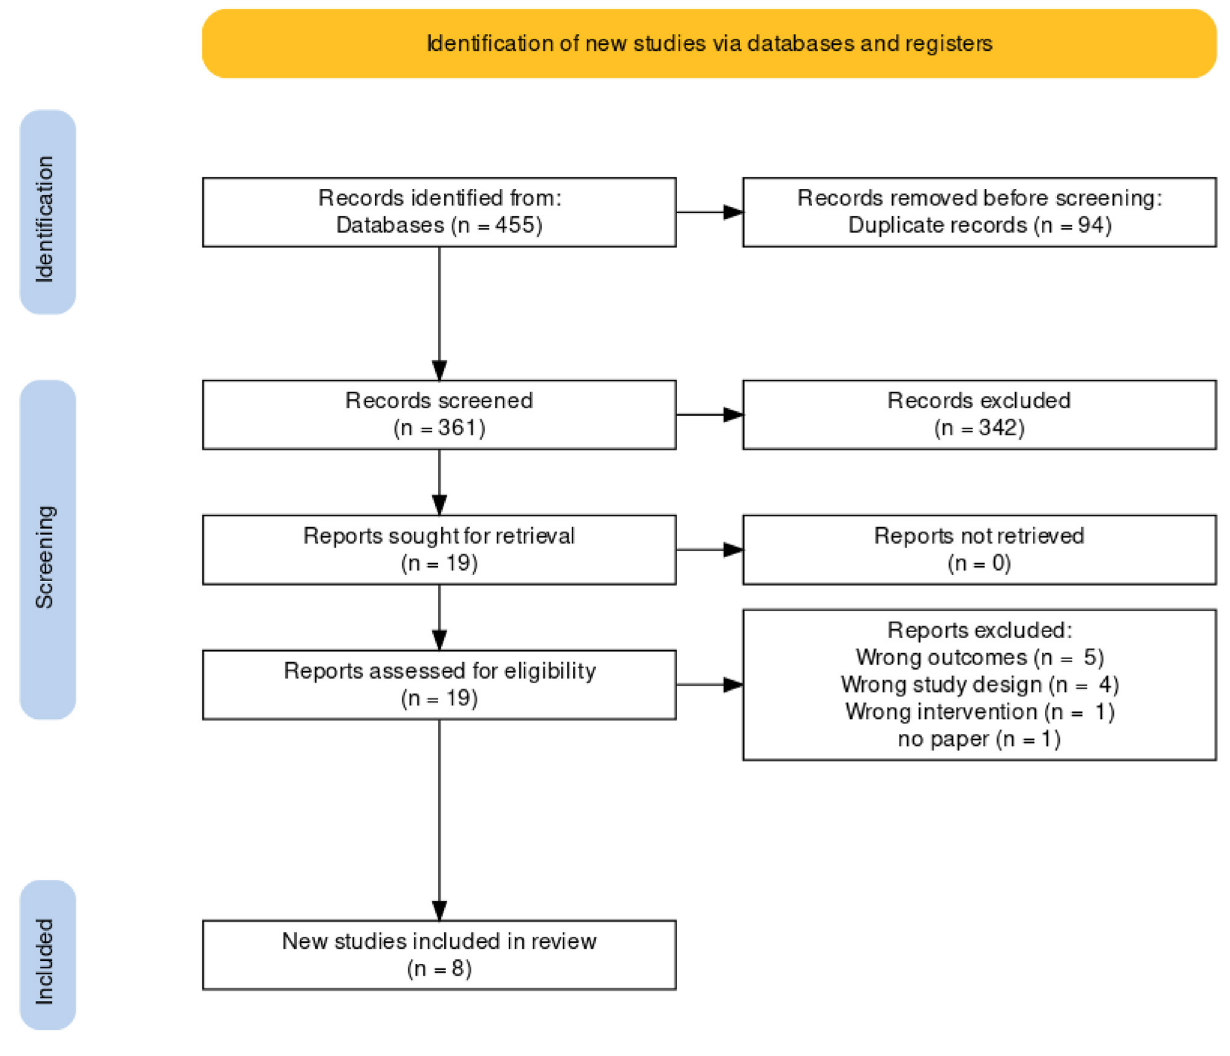
FIGURE 1 | PRISMA